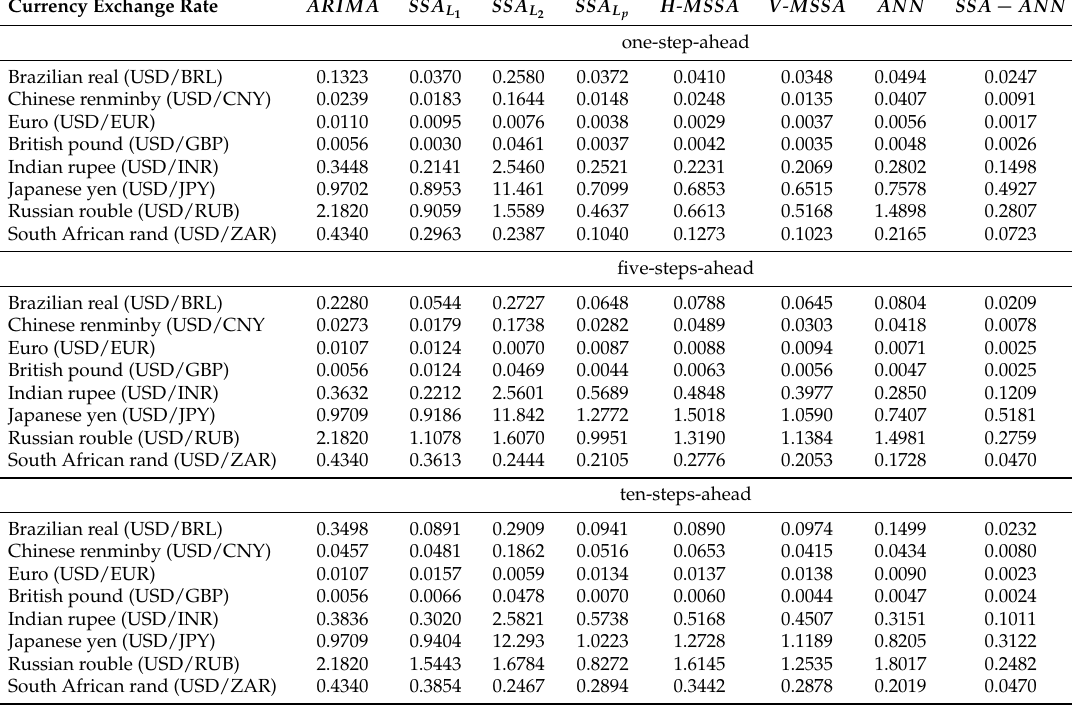
Table 7. Root mean square error for model forecasting for each of the eight currency exchange rates, considering each of the eight models/algorithms, ARIMA, SSA for the window length and number of eigentriples for reconstruction as defined in Table 3, multivariate SSA for the window length and number of eigentriples for reconstruction as defined in Table 3, ANN, and the hybrid method that combines SSA and